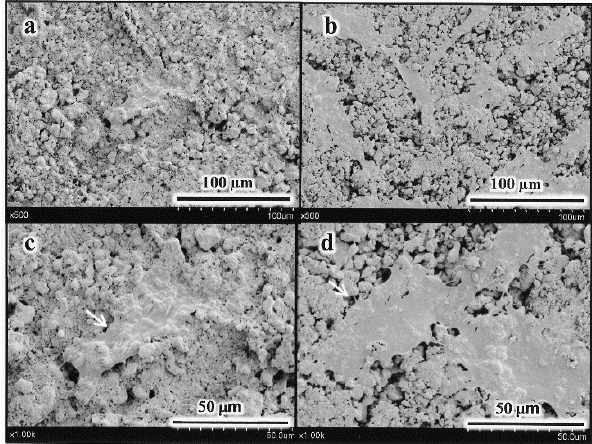
Figure 3. Typical scanning electron microscope (SEM) images of the surfaces for ( a , c ) c-AC and ( b , d ) AC(ate) after cell culturing for three days. Original magnification lower ( a , b ) and higher ( c , d ).